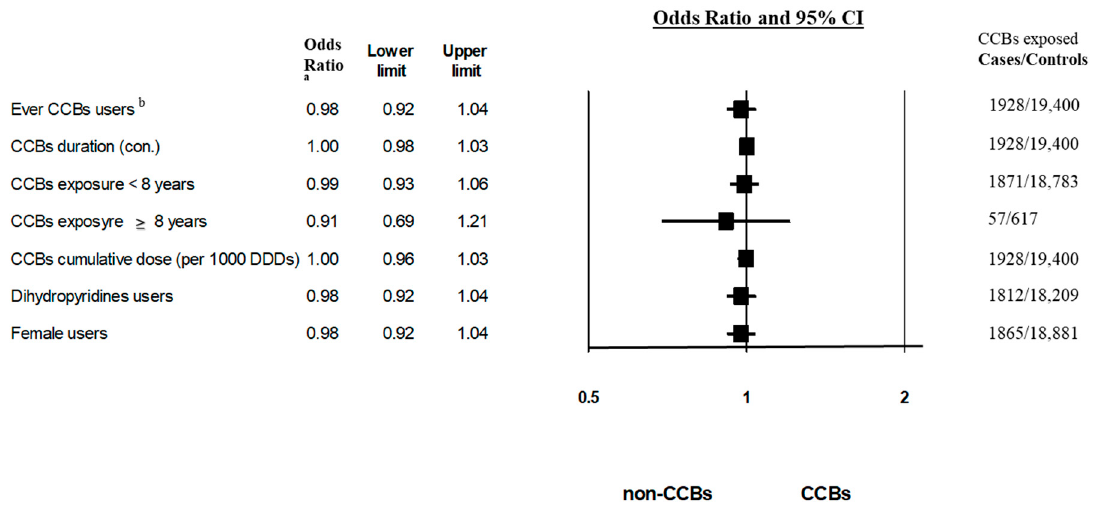
Figure 2. Adjusted odds ratios of breast cancer among calcium channel blocker users. a Univariate analysis. b Multivariate analysis, adjusted for socioeconomic status, smoking status, exposure to hormone replacement therapy, family history of breast cancer, and comorbidity score (counting diagnosis of 7 chronic diseases). CCBs—calcium channel blockers; CI—confidence interval; DDD— defined daily dose; OR—odds ratio.